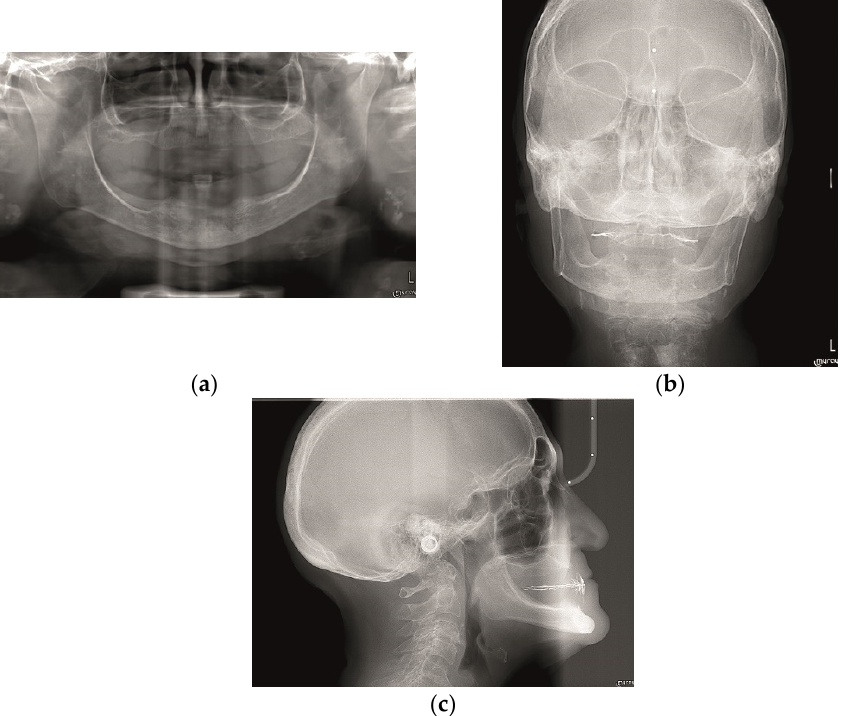
Figure 2. Initial radiographic images: ( a ) initial orthopantomography (OPT); ( b ) initial antero-posterior teleradiography (AP Ceph); ( c ) initial latero-lateral teleradiography (Lat Ceph).